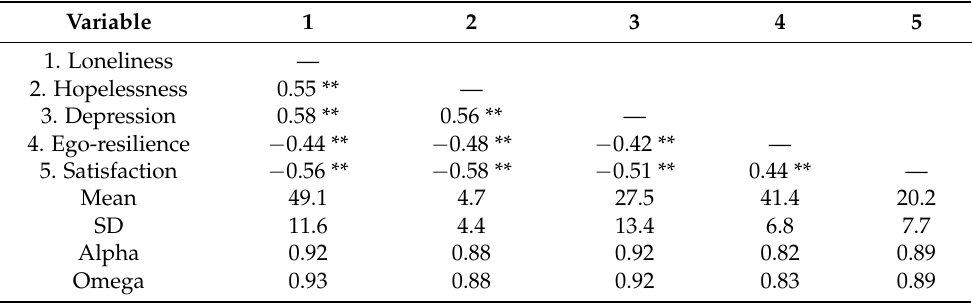
Table 1. Descriptive statistics, inter-correlations and reliabilities for the study